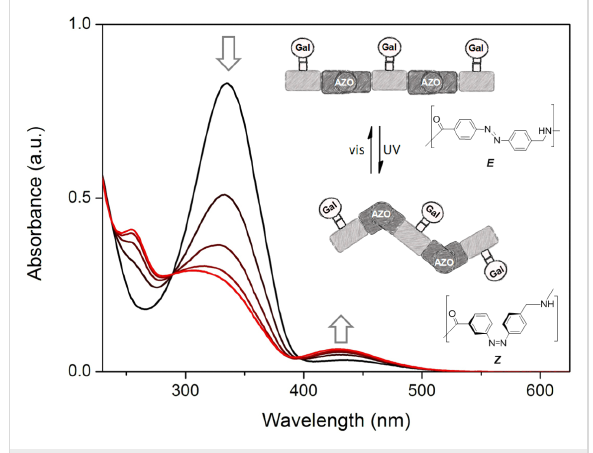
Figure 2: Characterization of the E → Z photoisomerization ( λ = 360 nm) of Azo-Gal(1,3,5)-5 in buffer solution at 25 °C via UV–vis absorption spectroscopy measurements.